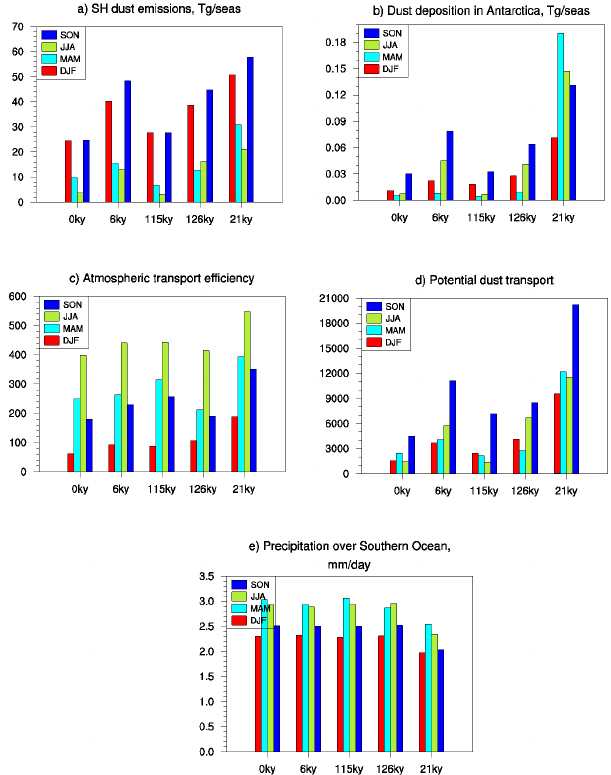
Figure 8. (a) Southern Hemisphere dust emission (Tgseason − 1 ), (b) dust deposition in Antarctica (Tgseason − 1 ), (c) atmospheric transport efficiency (trajectoriesseason − 1 ), (d) potential dust trans- port (arbitrary units) and (e) precipitation over the ocean south of 40 ◦ S (mmday − 1 ) for the interglacial and glacial simulations. At- mospheric transport efficiency is the number of trajectories origi- nated at 500 and 800hPa (combined) from a single dust source grid box per season and reached Antarctica within 10